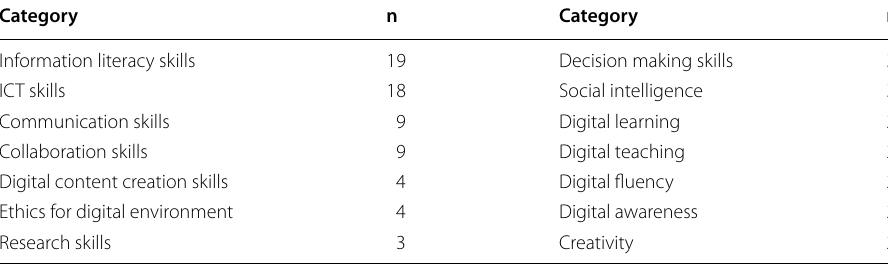
Table 5 Categories under ’skills’ major theme Category n